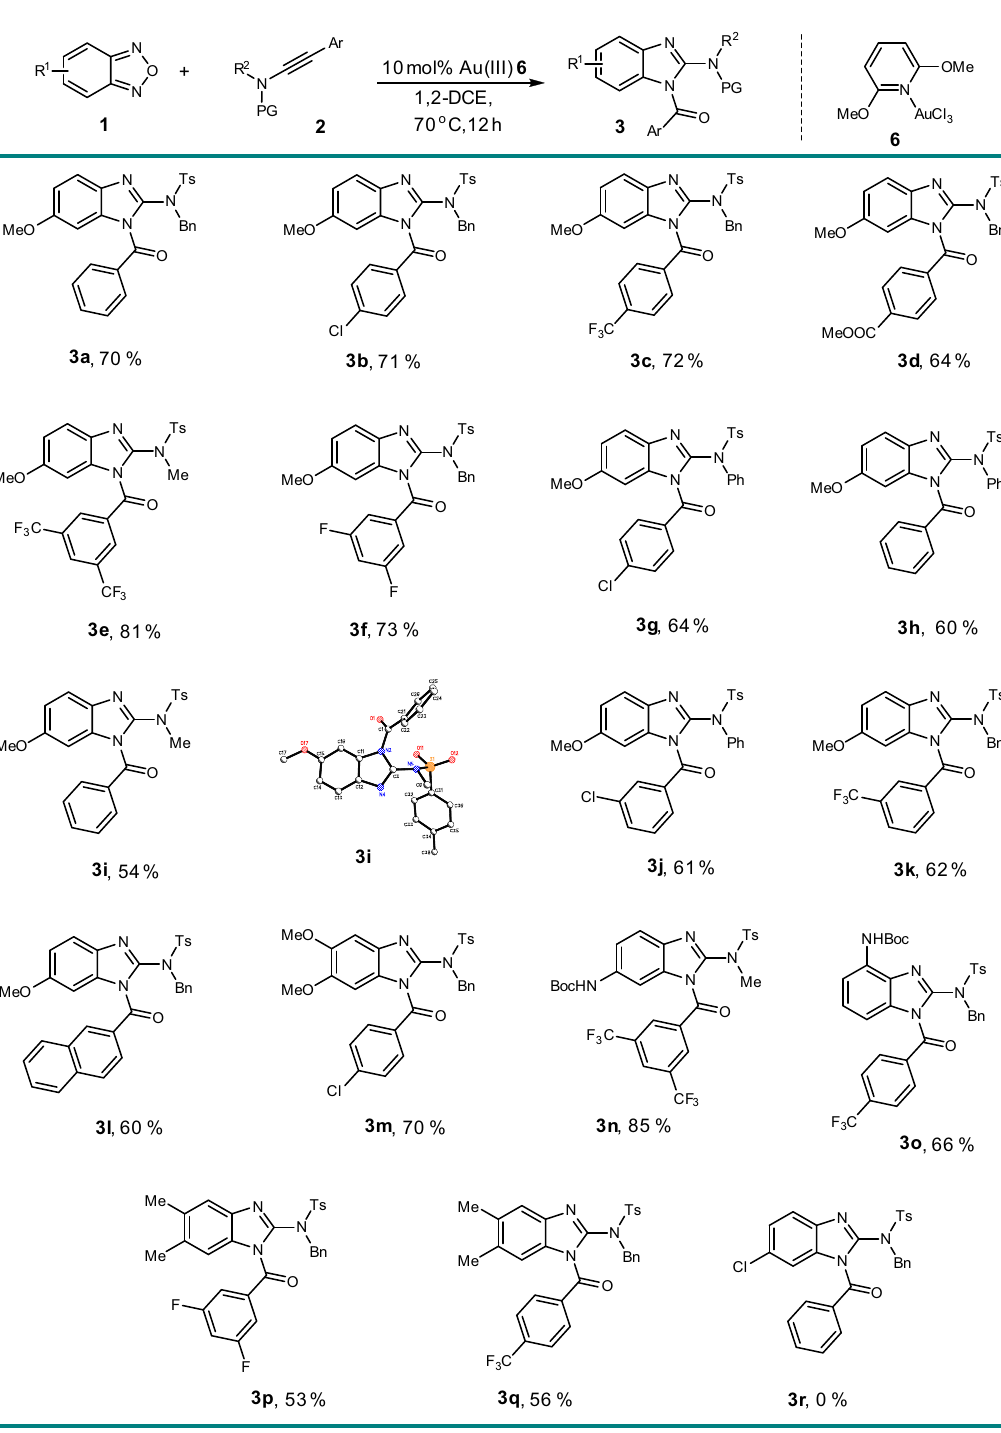
Fig. 3 Scope with respect to the Au(III)-catalyzed tandem annulations. Reaction conditions: 1 (0.4 mmol), 2 (0.1 mmol), 10 mol% Au(III) catalyst 6 in 4 ml 1,2- dichloroethane at 70 °C for 12 h. Isolated yields were